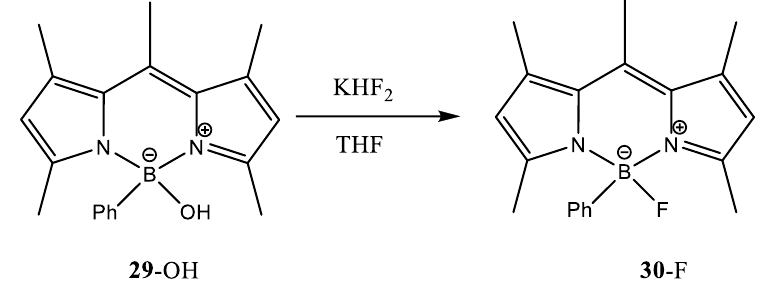
Figure 7. Nucleophilic[ 18 F]-radiolabeling of a BODIPY dye.